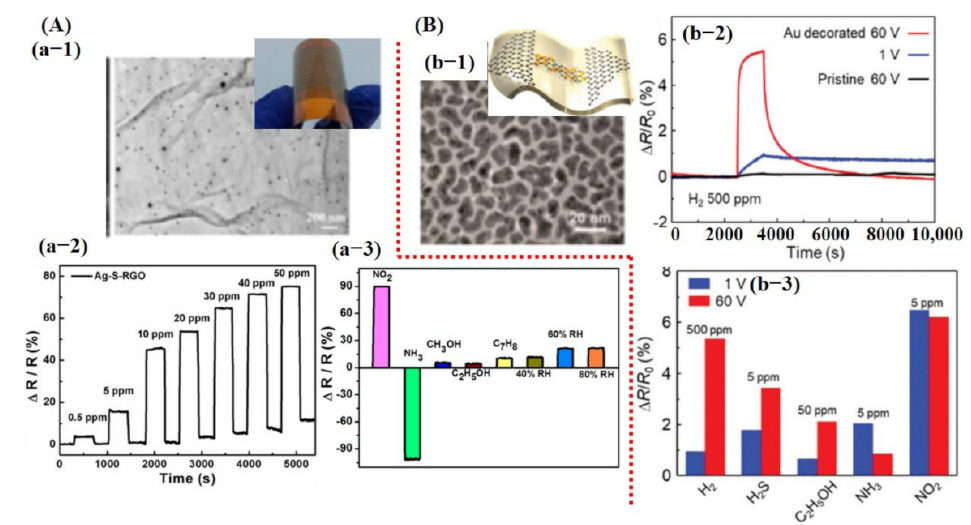
Figure 5. Experimental results of graphene-based gas sensors: ( A ) Ag NPs decorated on sulfonated reduced graphene oxide (Ag-S-rGO) and their sensing performance for NO 2 and NH 3 detection: (a-1) SEM image of Ag-S-rGO. Uniformly distributed Ag NPs can be seen on S-rGO surface. (a-2) Sensor response graph towards different concentrations of NO 2 gas indicating good sensitivity, fast response/recovery, and linear change in sensor response at different concentrations. (a-3) Response graph to different gases/compounds including 100 ppm NO 2 , 1 mL (13 ppt) of NH 3 , 1 mL (46 ppt) of methanol, 1 mL (32 ppt) of ethanol, 1 mL (18 ppt) of toluene, 40% RH, 60% RH, and 80% RH. Reproduced with permission from [103], copyright 2014 ACS. ( B ) The results for Au @ graphene to detect H 2 gas: (b-1) SEM image of Au@graphene; inset shows the schematic image of the device. (b-2) The response of pristine graphene and Au@graphene to 500 ppm H 2 gas when 1 V and 60 V DC was applied. Sensor shows the maximum response when 60 V was applied, indicating the importance of biasing voltage. (b-3) A cross-sensitivity graph, suggesting very poor selectivity of the fabricated sensor. Reproduced with permission from [104], copyright 2019